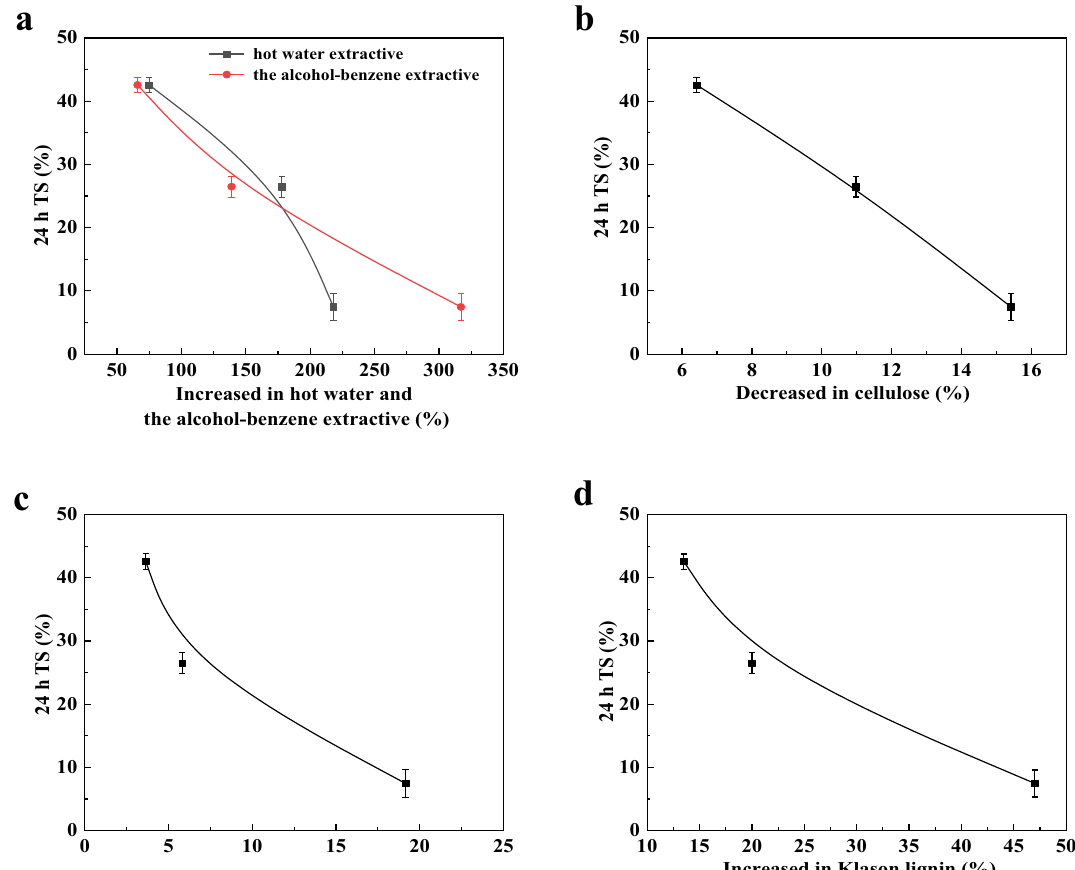
Fig. 8 Correlation between the change of chemical composition and TS of binderless board. a Effect of an increase in extractive on 24 h TS of binderless board. b Effect of a decrease in cellulose on 24 h TS of binderless board. c Effect of a decrease in hemicellulose on 24 h TS of binderless board. d Effect of an increase in Klason lignin on 24 h TS of binderless board. Error bars indicate standard deviations